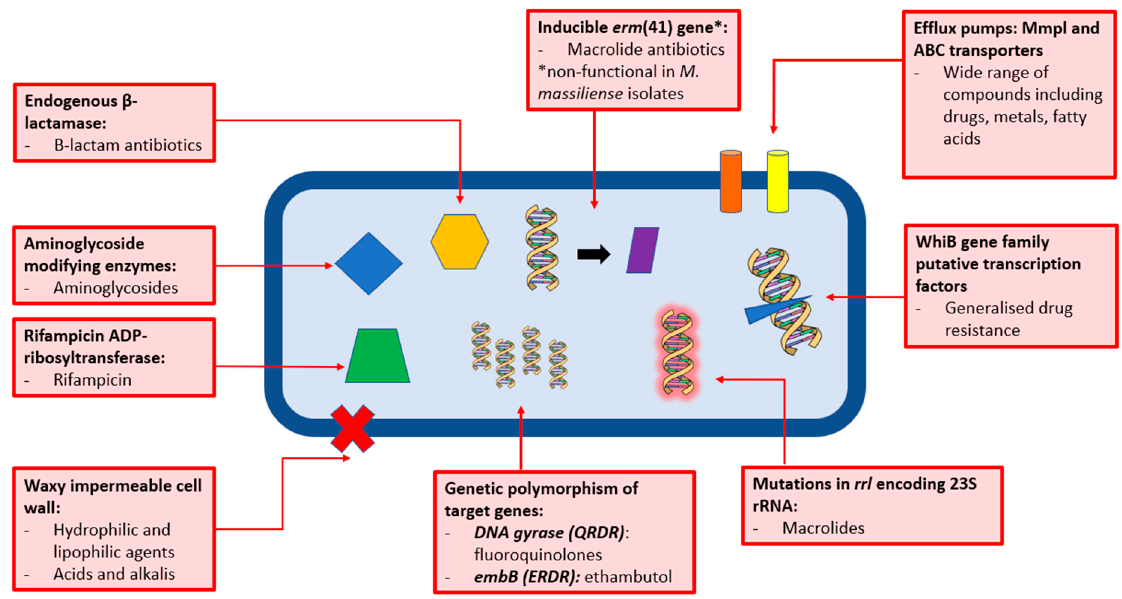
Figure 3. Graphical summary of the resistance mechanisms exhibited by Mycobacterium abscessus ( M. abs ). There are several mechanisms involving different physiological, enzymatic and genomic processes that contribute to the notoriously drug-resistant profile of M. abs . It is likely that these processes, such as efflux pumps and drug resistance genes, work in synergy to produce a highly resistant pathogen.